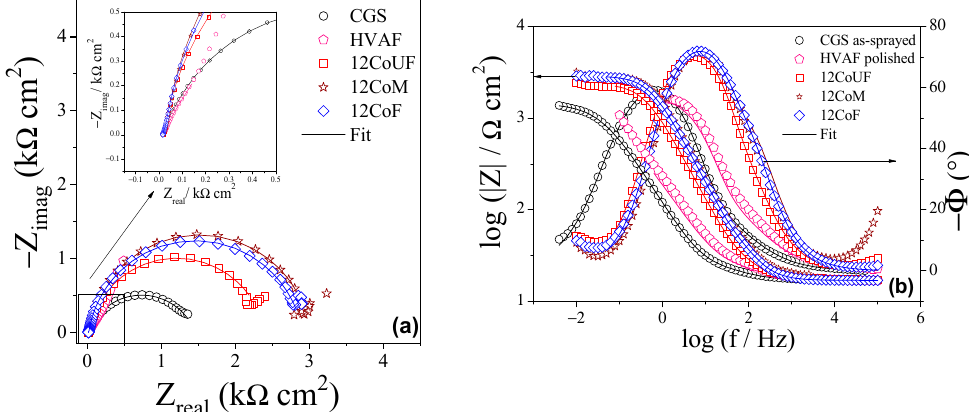
Figure 8. ( a ) Complex plane plots and ( b ) impedance moduli and phase angle Bode plots for as- sprayed CGS and polished samples obtained in aerated and unstirred 3.56 wt% NaCl aqueous solution at 25 ◦